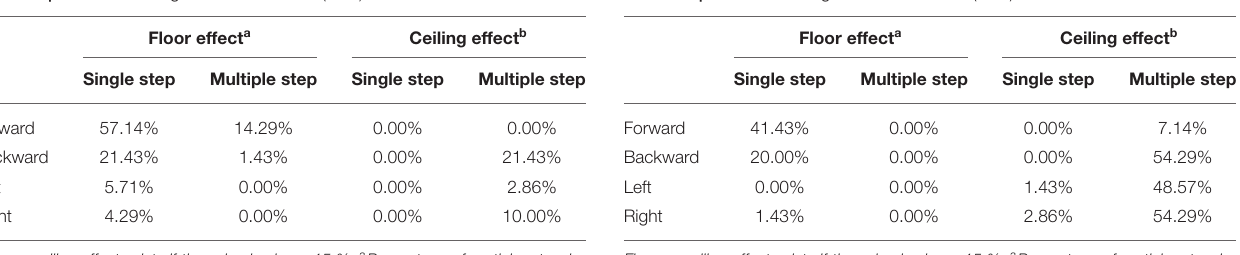
TABLE 7 | Floor and ceiling effects of the STT (ACE). TABLE 8 | Floor and ceiling effects of the STT